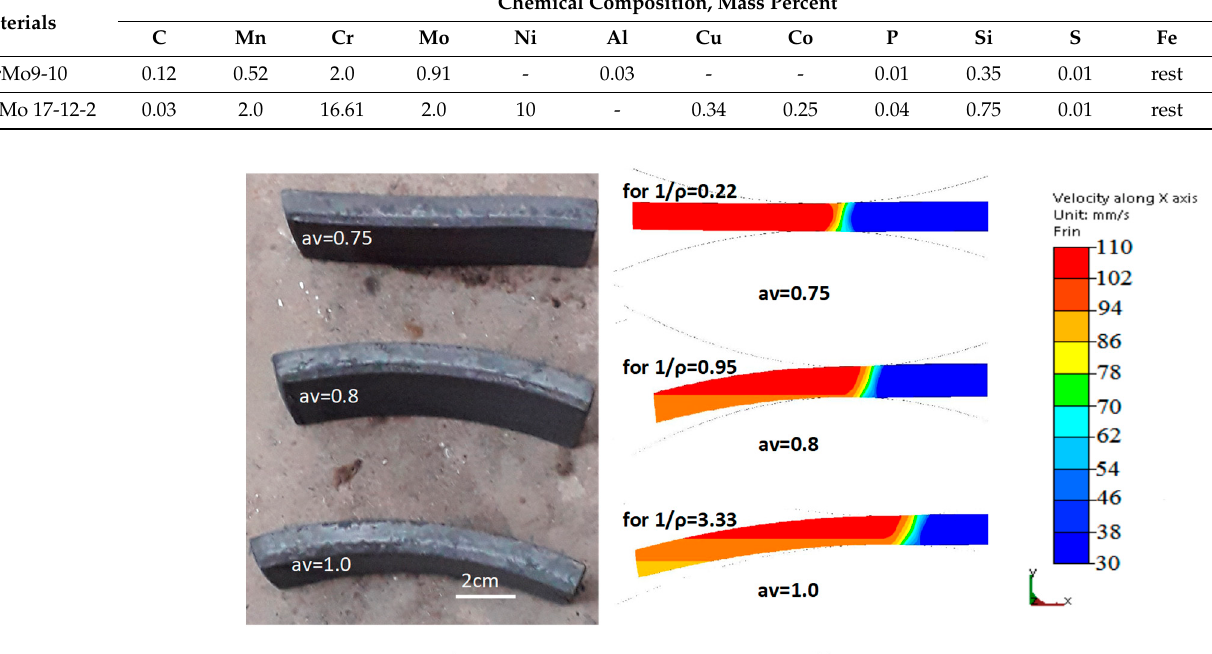
Figure 6. Relationship of the bimetallic sheet metal curvature on the kinetic asymmetry coefficient of the work rolls a v for the deformation ε = 0.18.